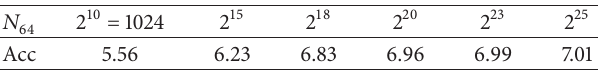
Table 4: The results of experiments (data are transmitted through four 32-bit high-performance ports and 𝜂 = 32 ).